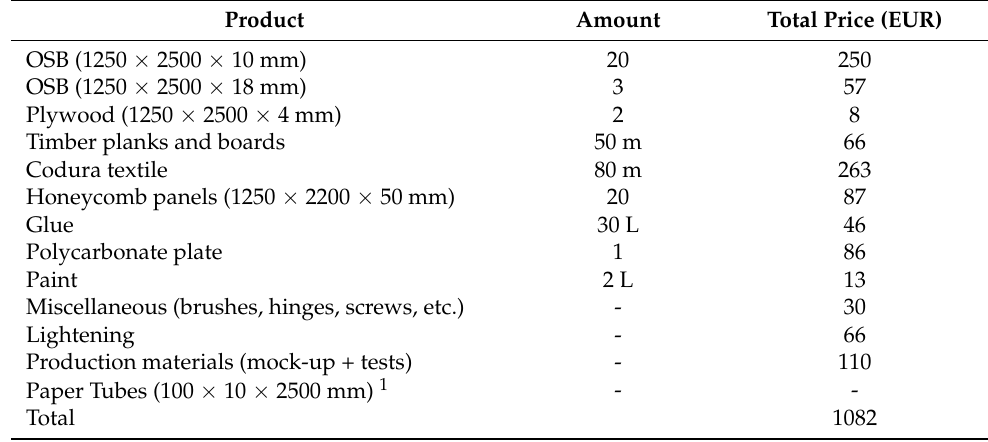
Table 1. The Obverse/Reverse Pavilion budget. The presented costs do not include transportation and human labor. The pavilion can be considered low-cost as the structure with an area of 26.6 m 2 had a budget slightly higher than 1000 EUR.